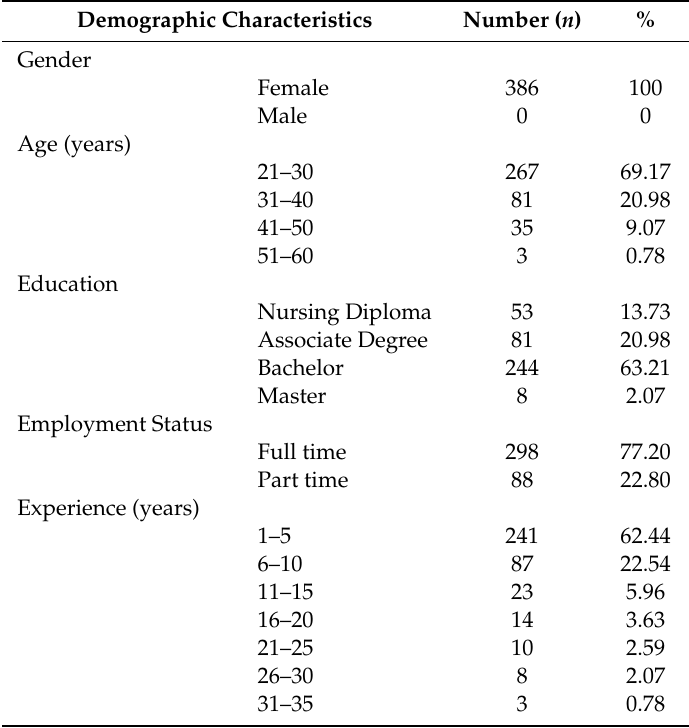
Table 1. Demographic